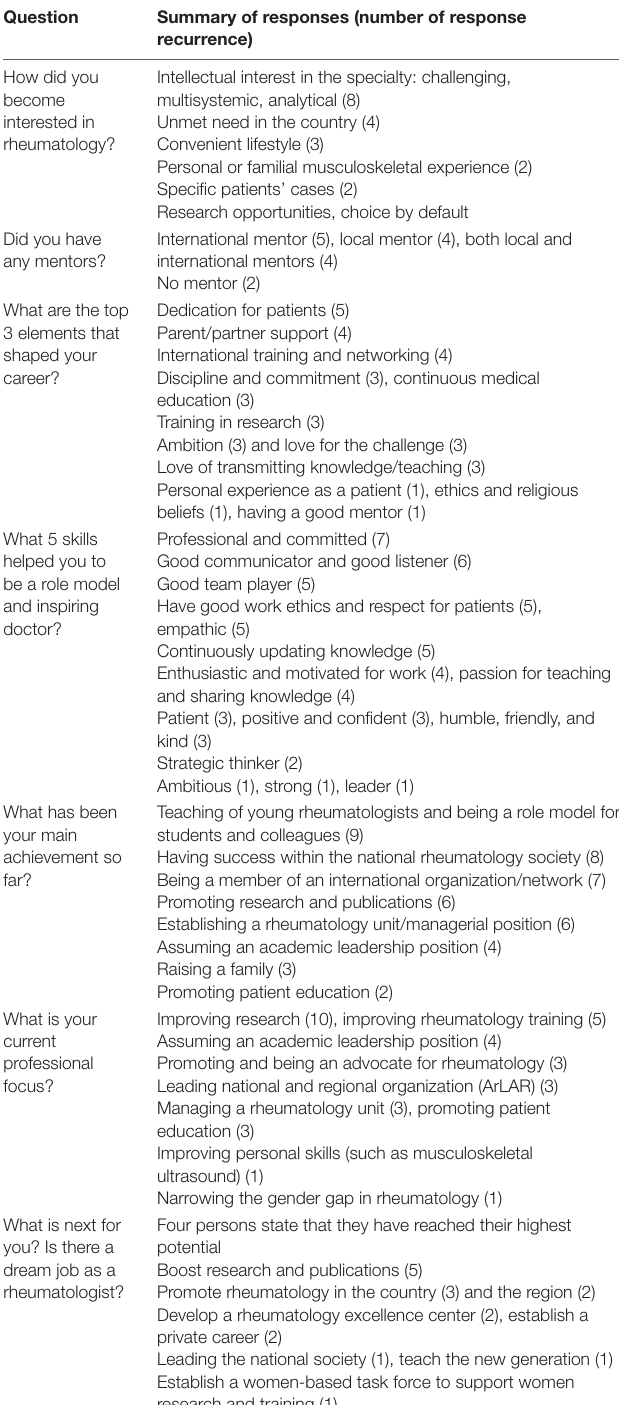
TABLE 2 | Summary of the interviews with women rheumatologists from the ArLAR countries regarding the rheumatologist’s career journey. Question Summary of responses (number of response